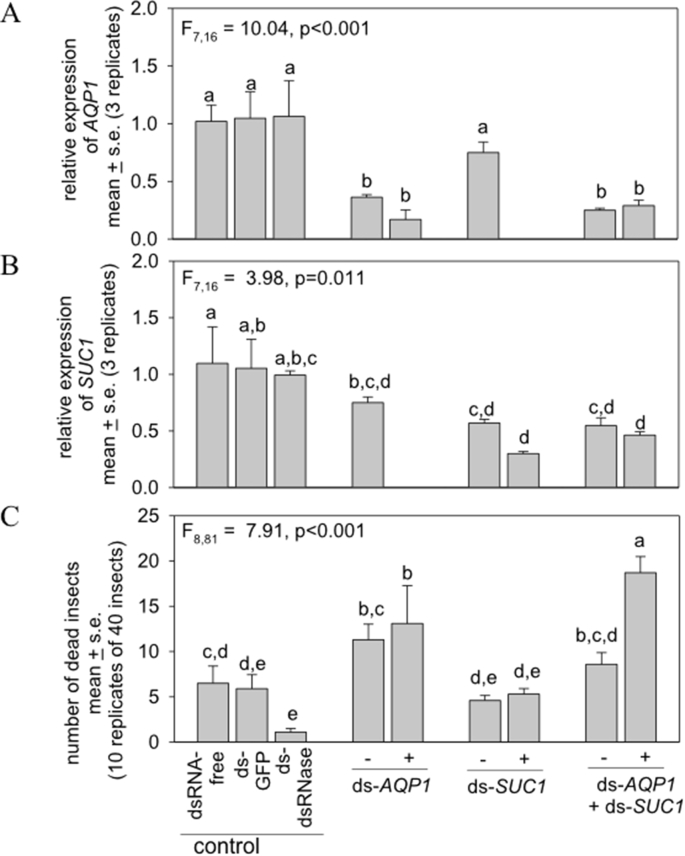
RNAi against osmoregulation genes in adult B. tabaci on artificial diet. dsRNA (100 ng μl−1 diet) were ds-GFP, ds-dsRNase1&2, and dsRNA against osmoregulation genes AQP1 and SUC1 with (+) or without (−) ds-dsRNase1&2 administered over 6 days. A&B. qRT-PCR analysis of AQP1 and SUC1 expression, respectively, relative to dsRNA-free diet, normalized to RPL13. Mean ± s. e, 3 reps. The expression of SUC1 in insects fed on ds-AQP1, and of AQP1 in insects fed on ds-SUC1, was quantified only in the presence of ds-dsRNase1&2. C. Number of dead insects (mean ± s. e. for 10 replicates of 40 insects) at day-6. Different letters indicate significantly different treatments by Fisher's LSD test.